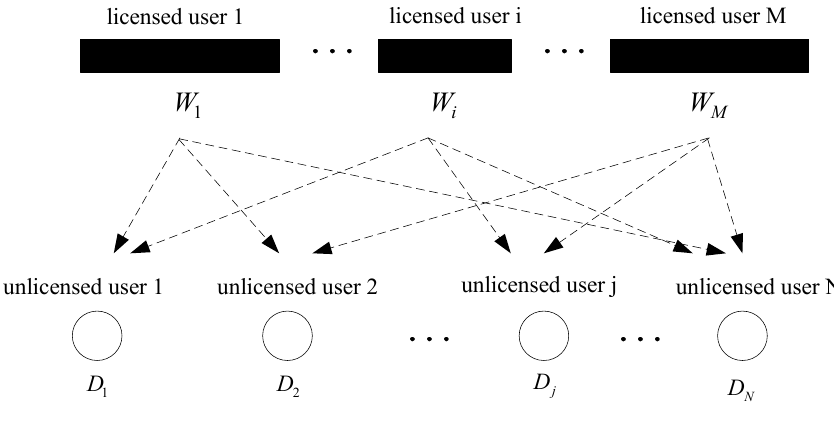
Figure 1. System Figure 1. System model.